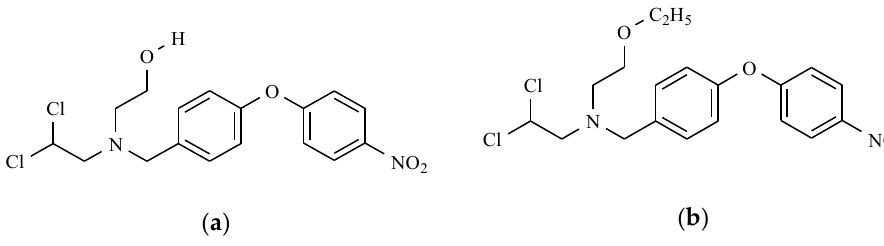
Figure 20. Nitrophenyl derivatives as antiprotozoal drugs: ( a ) Clefamide; and ( b ) Etofamide.